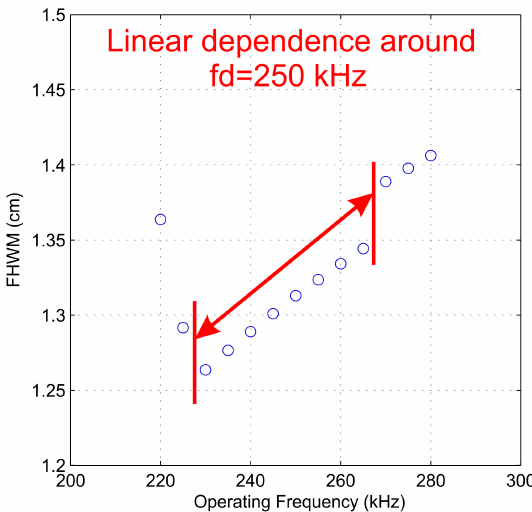
Figure 4. Full Width Half Maximum (FHWM) against operating frequency (simulation results).